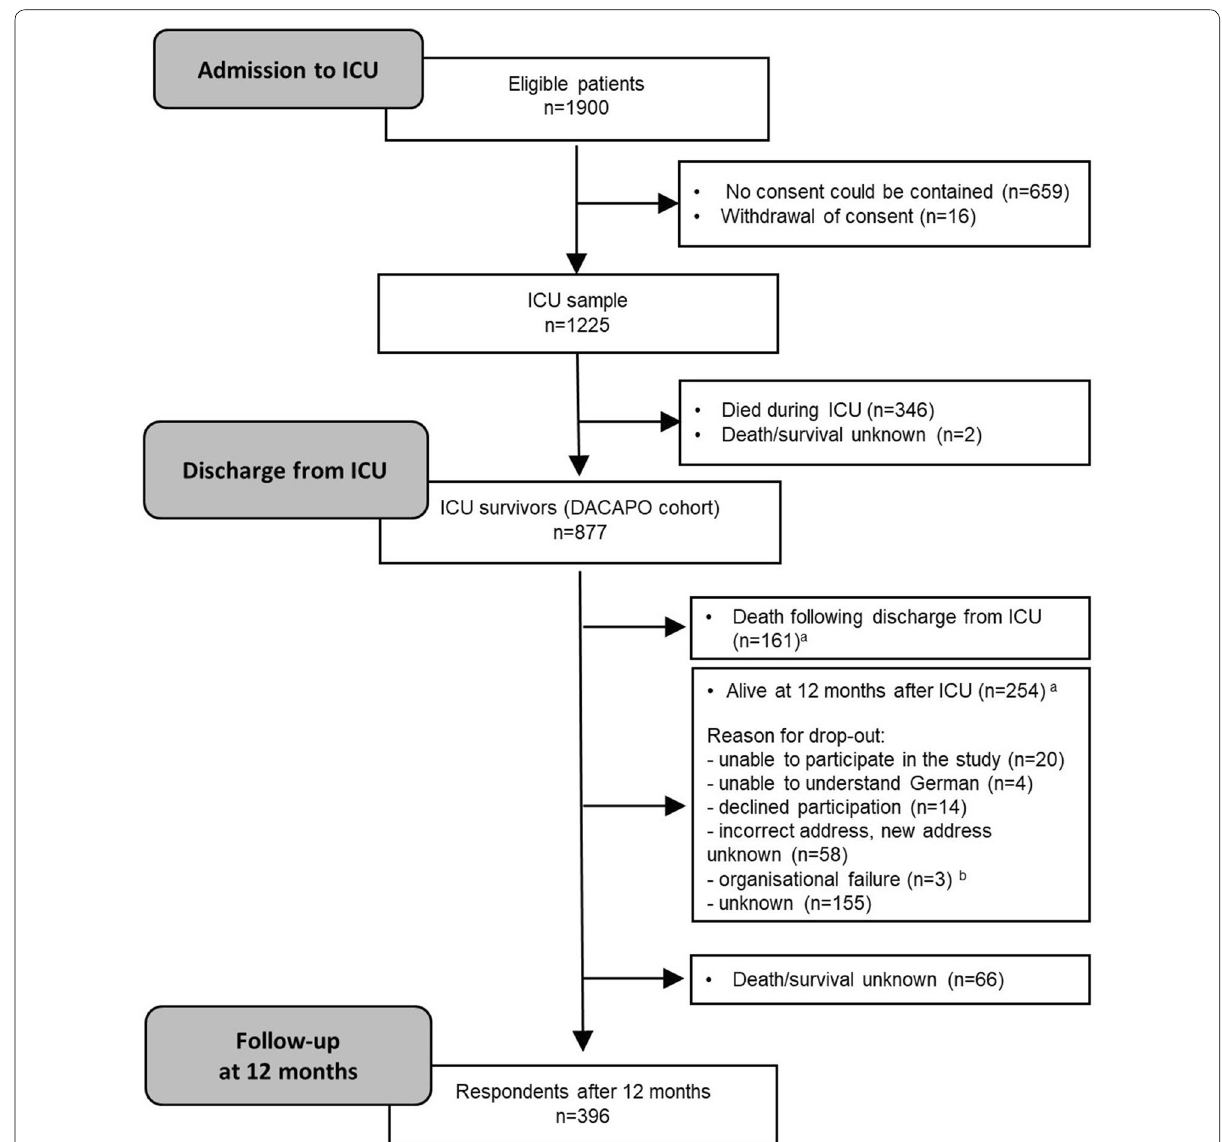
Fig. 1 Patient flow. Notes : ICU intensive care unit. a For all patients who were lost to follow‑up, survival was assessed via local municipal population registries. b Written informed consent and patient data were transferred to the study centre with a delay of more than 12 months; thus,